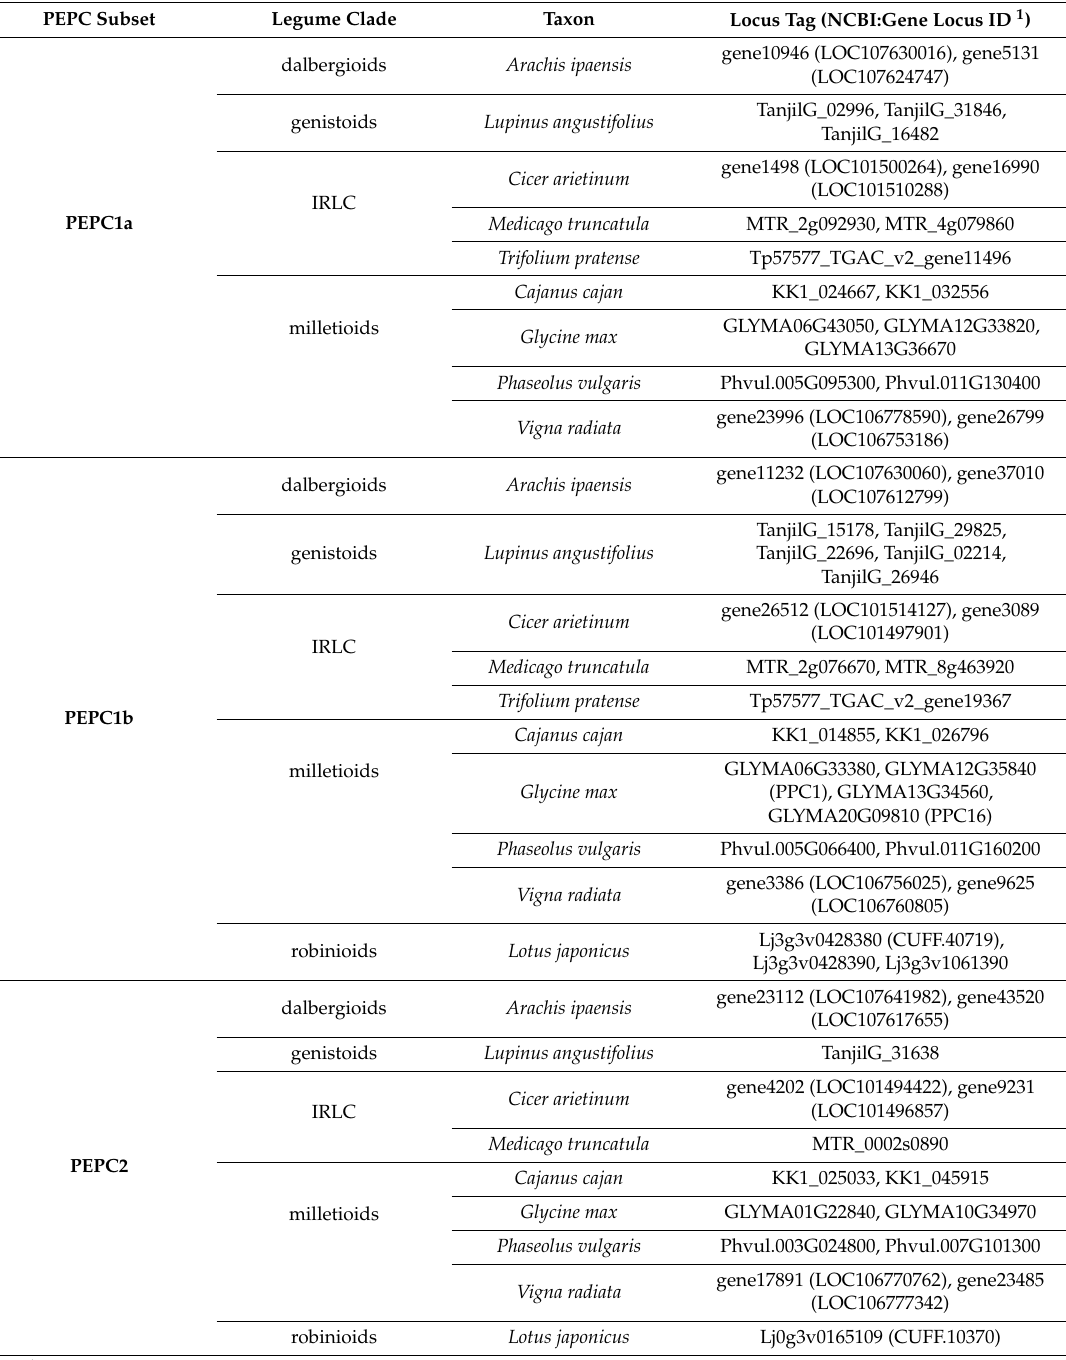
Table 3. Summary of major phosphoenolpyruvate carboxylase clades traced to the ancestral legume genome (monophyletic, support over